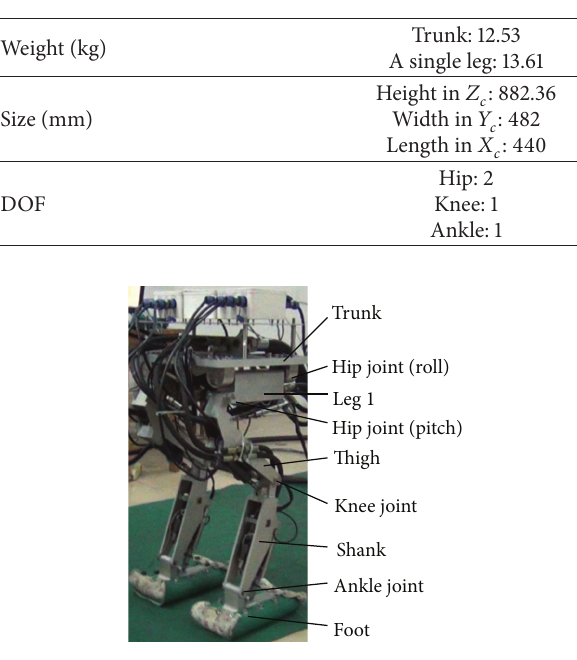
Table 1: Specifications of the hydraulic biped robot.